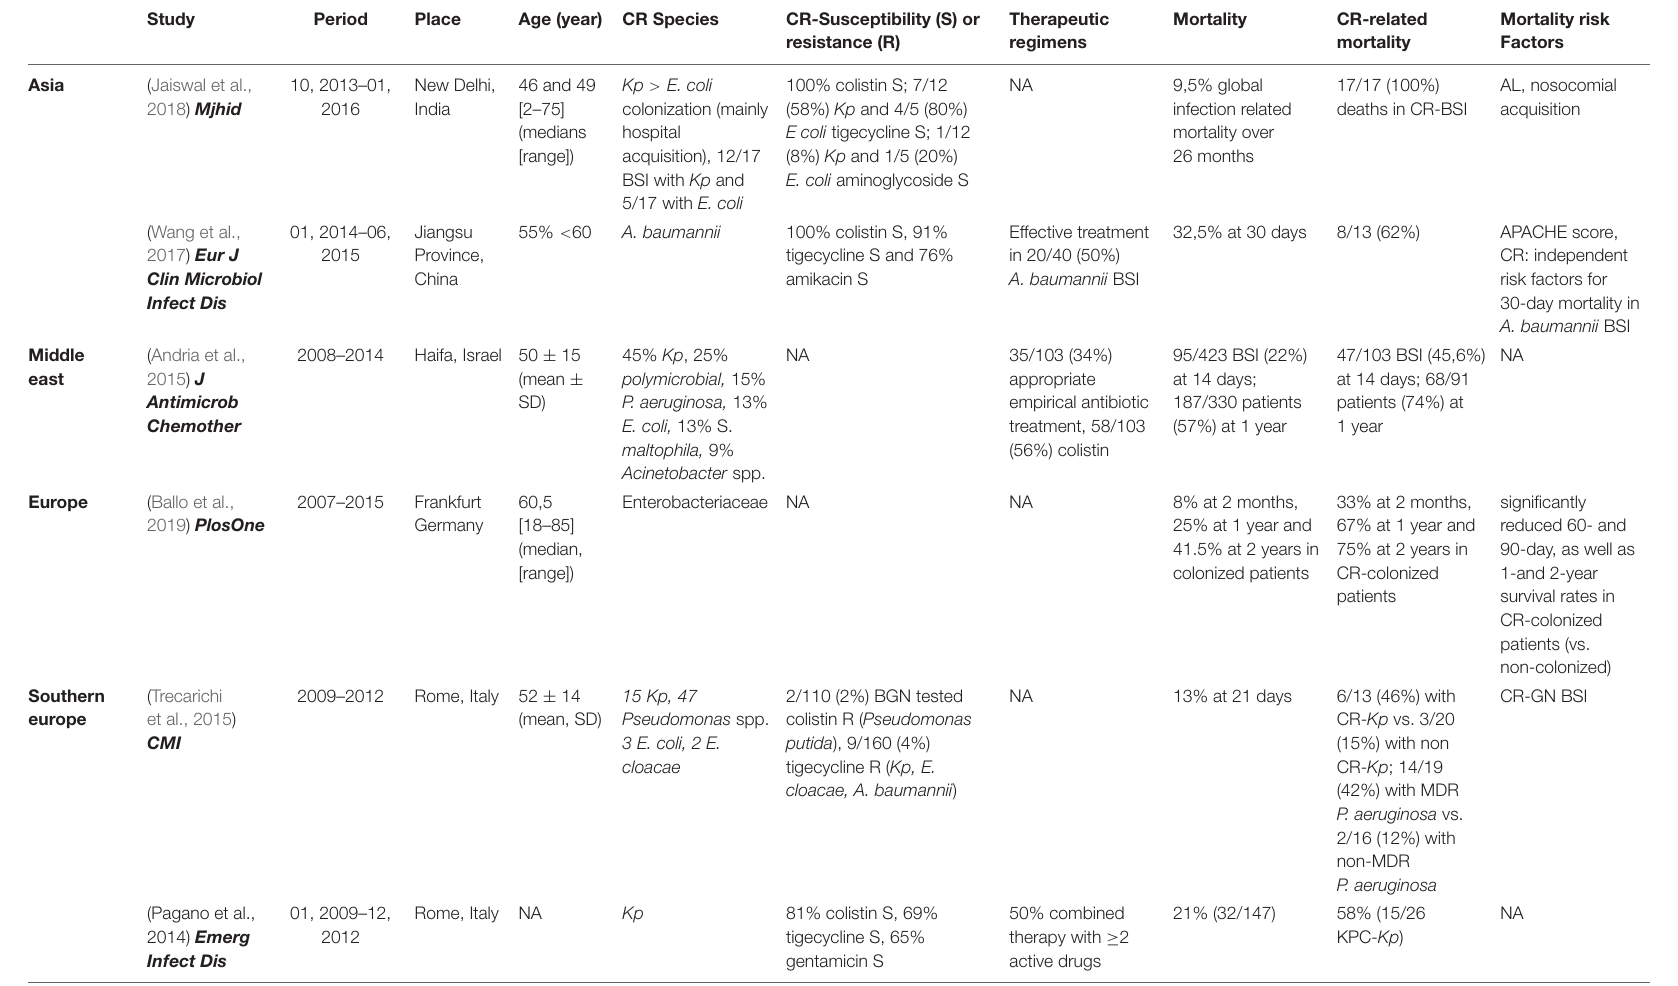
TABLE 2 | Characteristics of the studies reporting therapeutic management and mortality associated with CR bacteria in HM patients.